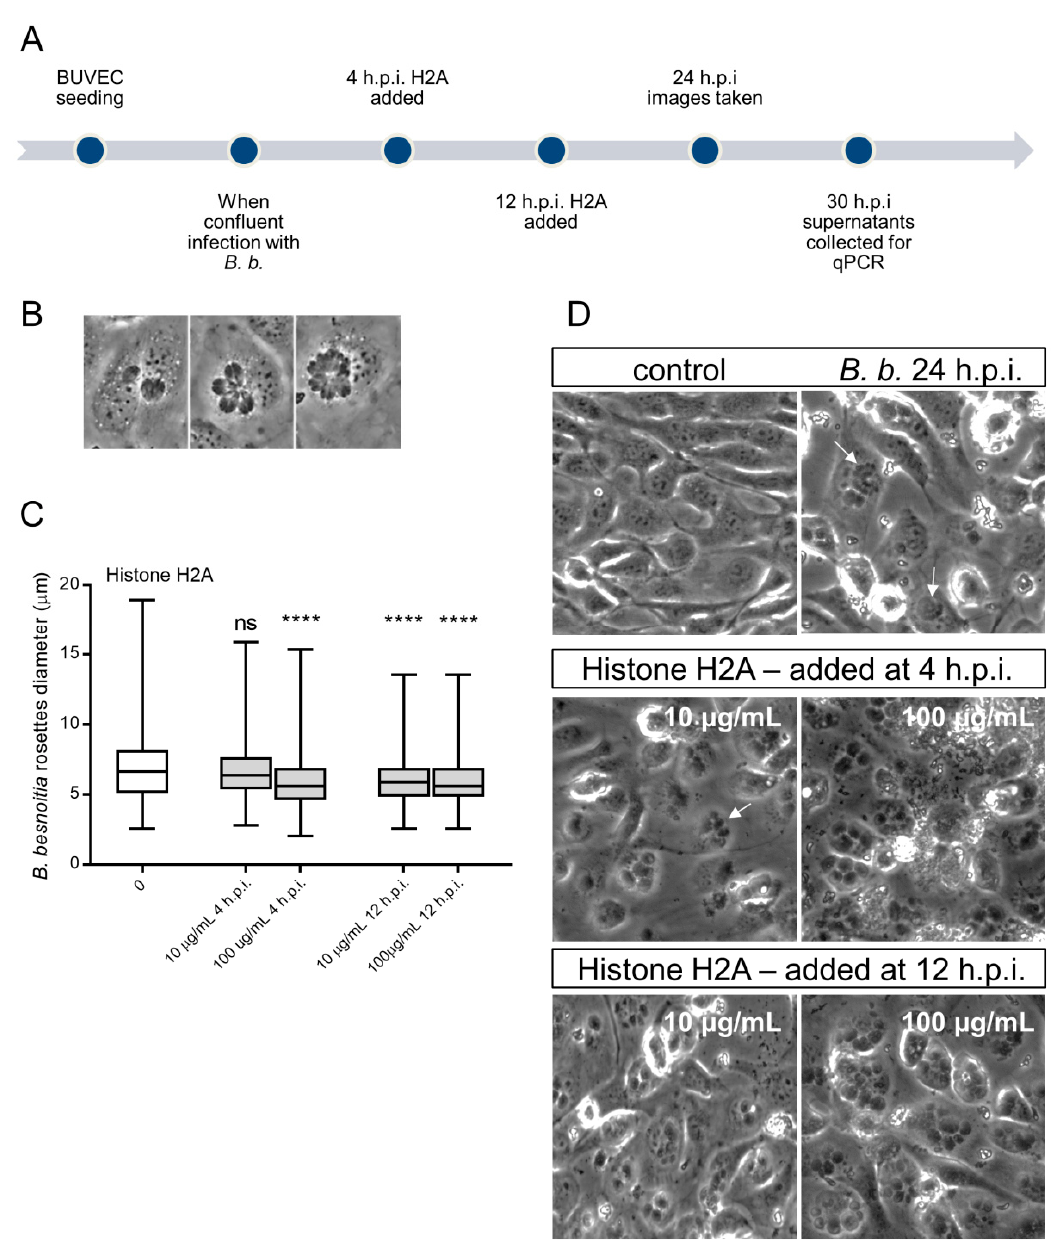
Figure 4. Histone 2A (H2A) treatment of B. besnoiti -infected BUVEC reduces B. besnoiti parasitophorous vacuole (PV) diameter. BUVEC (three di ff erent isolates, N = 3) were treated with H2A at 10 or 100 µ g / mL at 4 and 12 h.p.i. (for experimental procedure refer to Figure 4 A ). At 24 h.p.i. experimental conditions were documented by five randomly taken images using a phase contrast microscope ( B , D ). ( B ) Shows the typical development of B. besnoiti rosettes within 24 h of infection (non-synchronous tachyzoite division leads to the formation of 2-mers to 16-mers). Here, the diameter of each B. besnoiti PV was measured ( n = 825) and plotted as box and whiskers plot ( C ), line at median, bars indicating maximum and minimum values. Statistical significance, N = 3 (ns = non significant, **** p < 0.0001) was determined by Kruskal-Wallis test followed by a Dunn´s post-test comparing experimental versus control condition at 4 and 12 h.p.i. In ( D ) a representative image of each experimental condition is shown, white arrows indicate B. besnoiti rosettes inside host BUVEC cell.